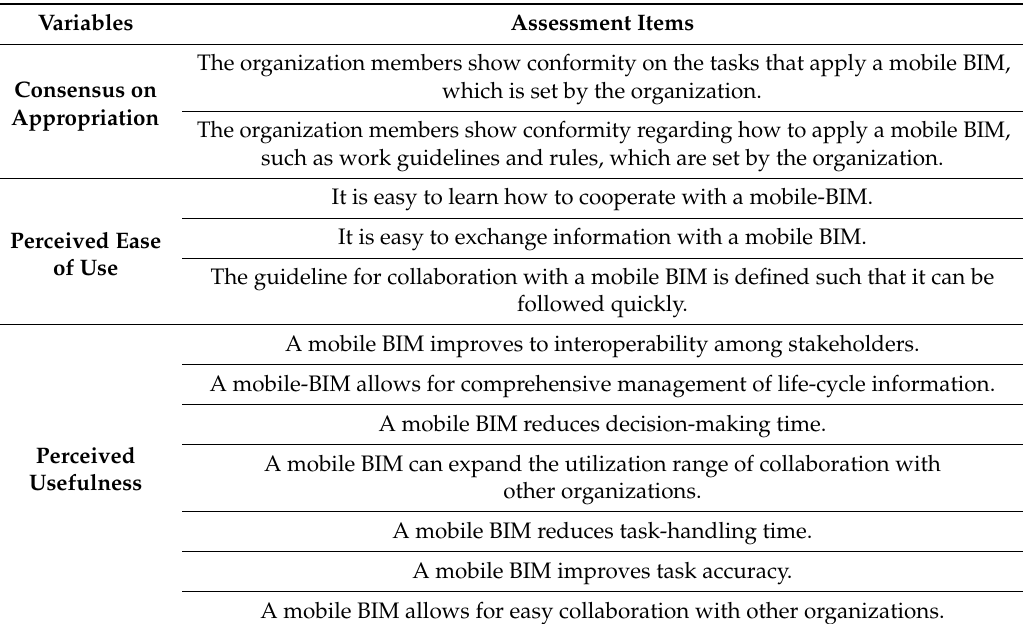
Table 6. Assessment items of internal variables for mobile BIM acceptance.